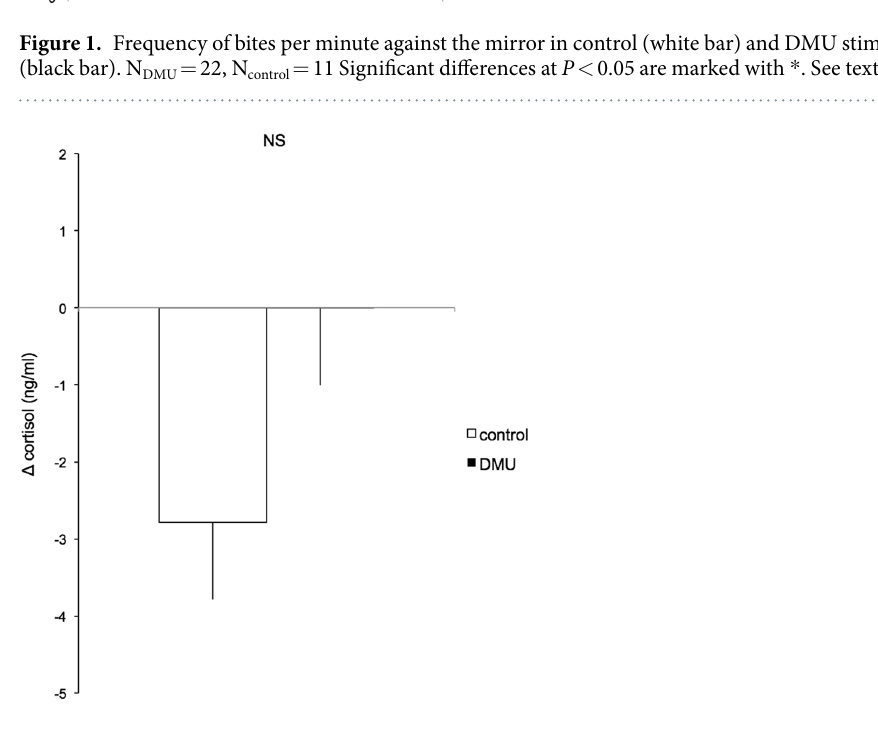
Figure 2. Changes ( Δ ) in urinary cortisol levels (as measured immediately after the mirror test and subtracted by the urinary cortisol levels measured 24 h before) in control (white bar) and DMU stimulated males (black bar). N DMU = 13, N control = 6. No significant difference was found between treatments (NS). See text for